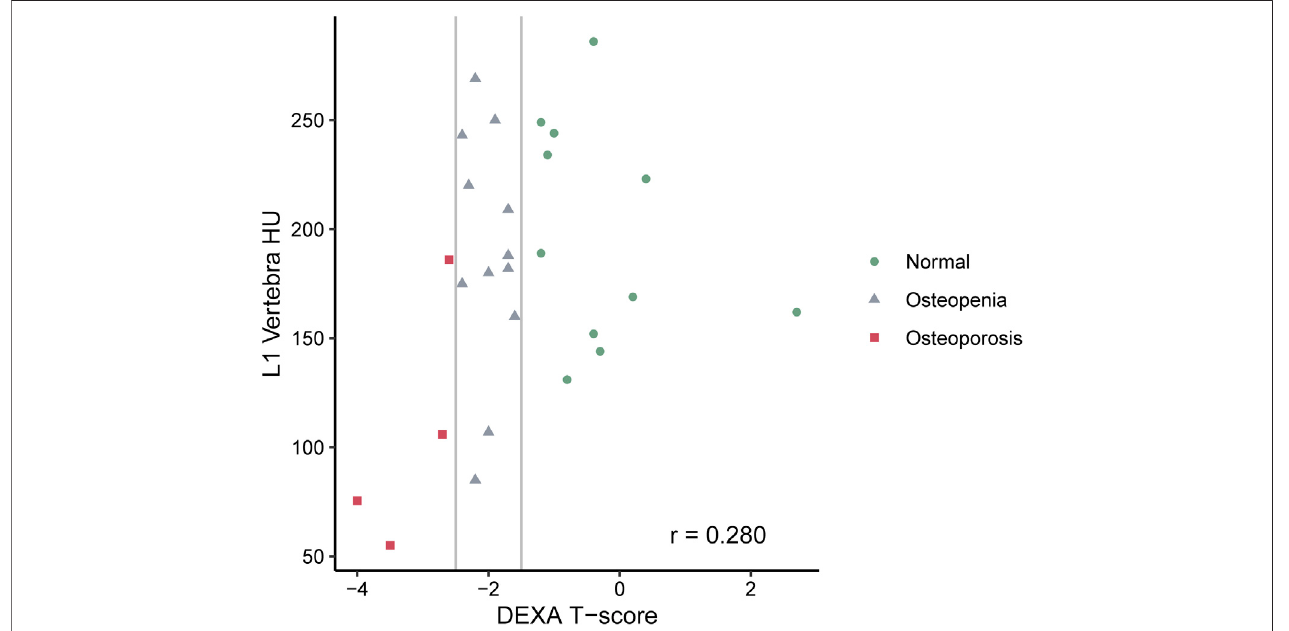
FIGURE 4 | Scatterplot of L1 density (HU) by DXA classi fi cation.